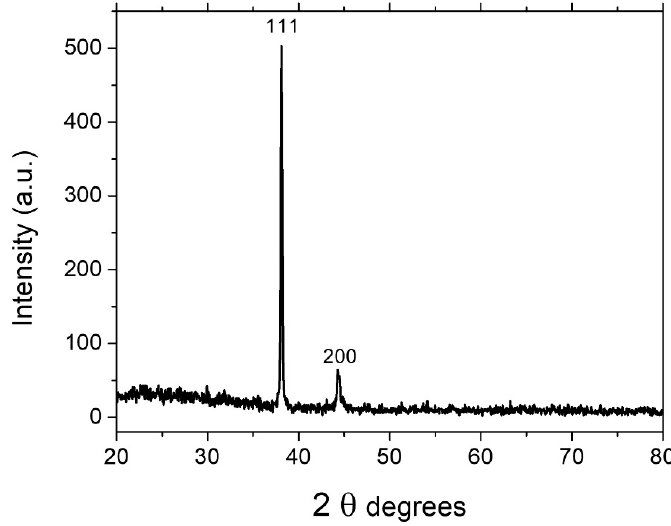
Figure 9. XRD pattern of the